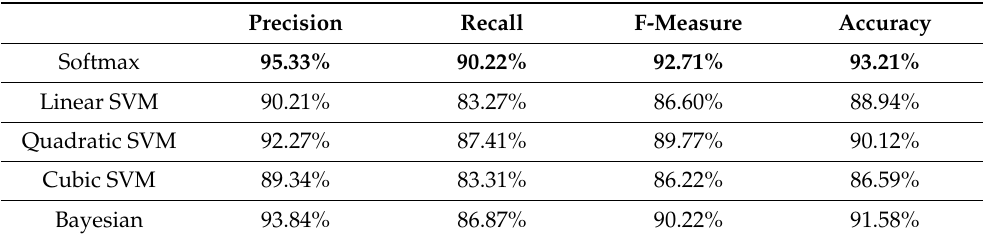
Table 6. Classification results for mixed dataset (original images + augmented contrast enhanced images).